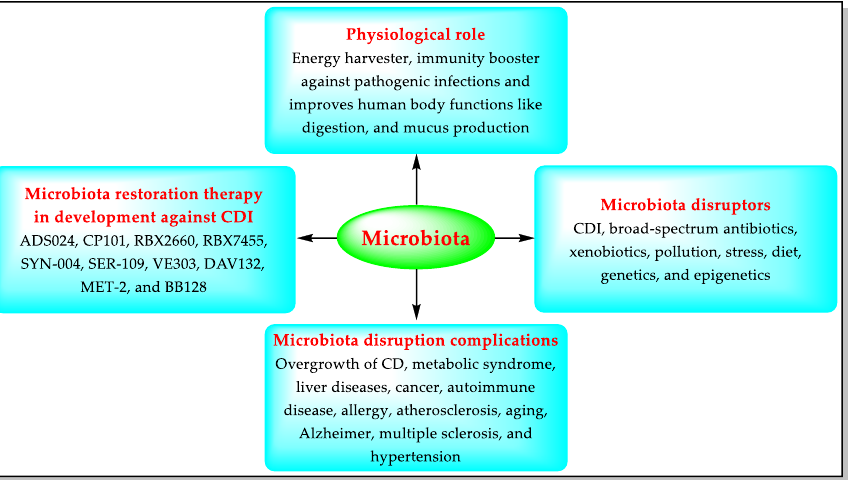
Figure 2. Functions of the microbiota, its disruptors, and microbiota-based CDI therapies in devel- opment.